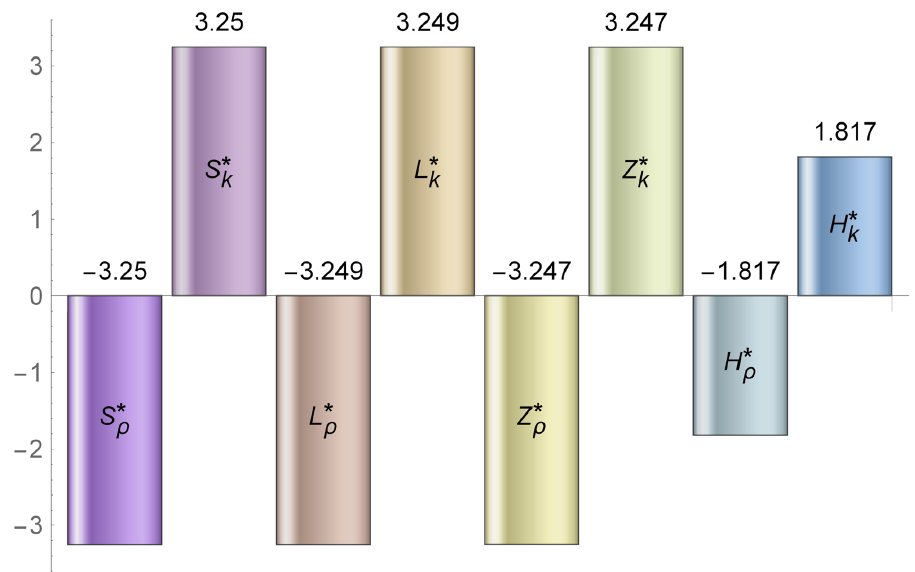
Fig 4. Sensitivity indexes of the equilibrium concentration of variables with respect to parameters ρ and k . Note, ρ negatively and k positively impacts equilibrium concentration of all model variables.